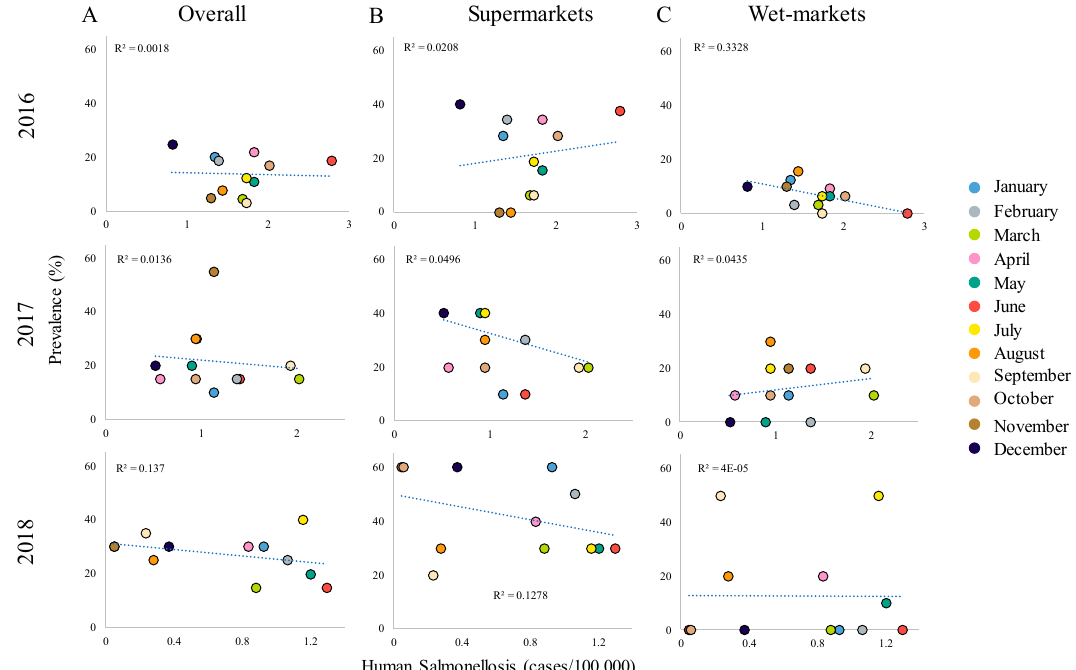
Figure 2. Correlation between Salmonella prevalence in chicken meat retailers and human salmonellosis cases. Analyses were performed using overall ( A ), supermarkets ( B ), wet-markets ( C ) Salmonella prevalence in chicken meat versus number of Salmonellosis cases.